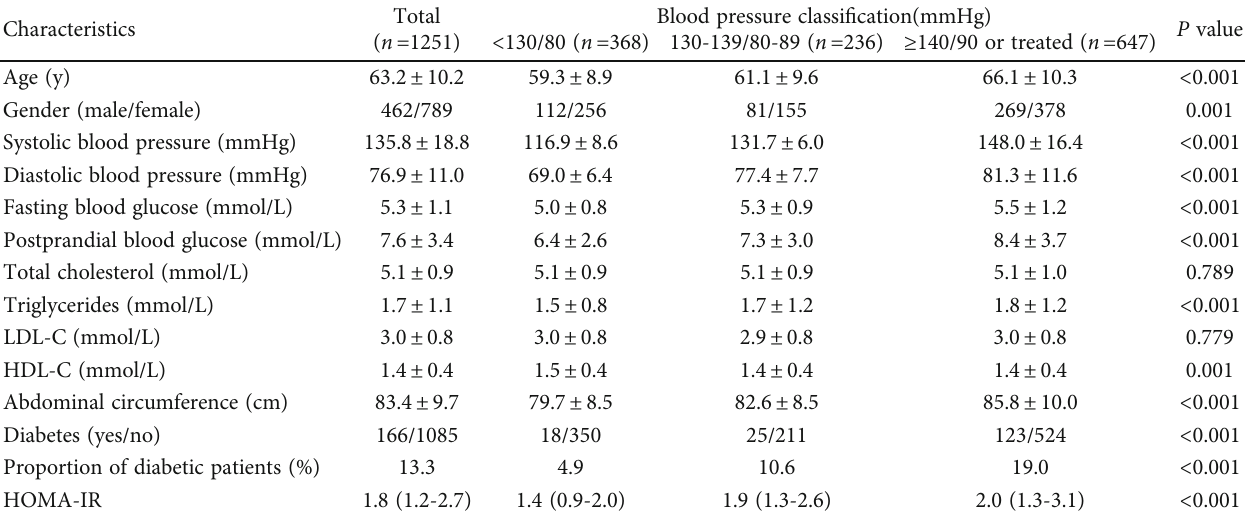
Table 1: Baseline characteristics of study participants [ − x ± s or median (IQR) or n ].